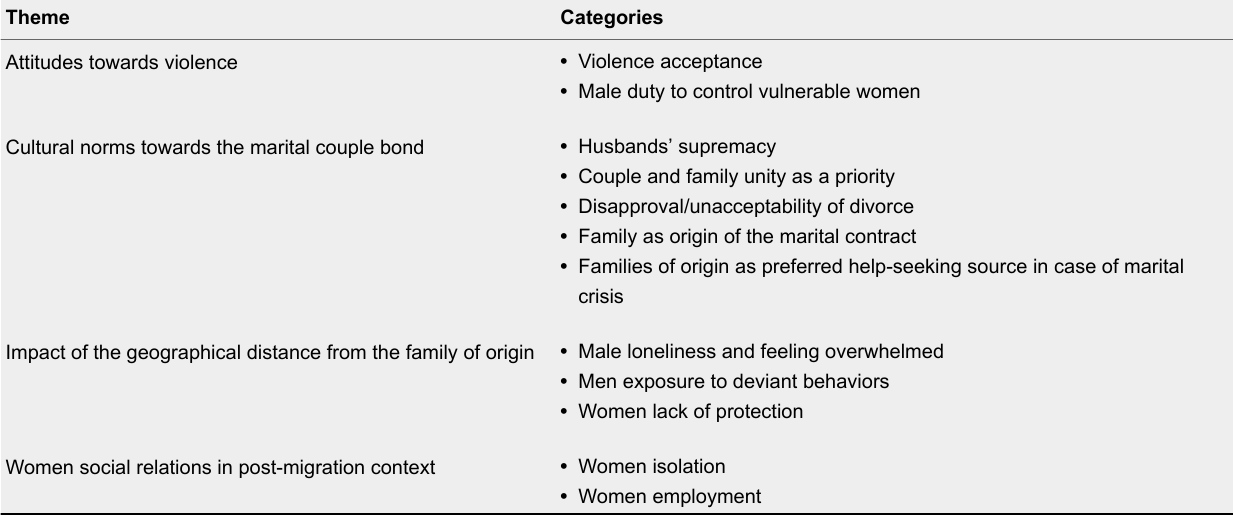
Themes and Categories Emerged From the Focus-Groups